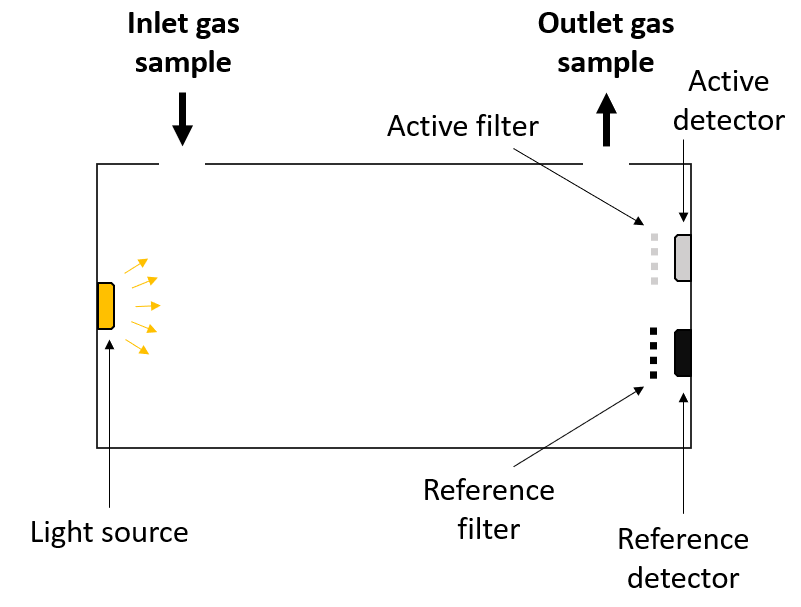
Figure 8. Schematic drawing of a non-dispersive infrared (NDIR) carbon dioxide